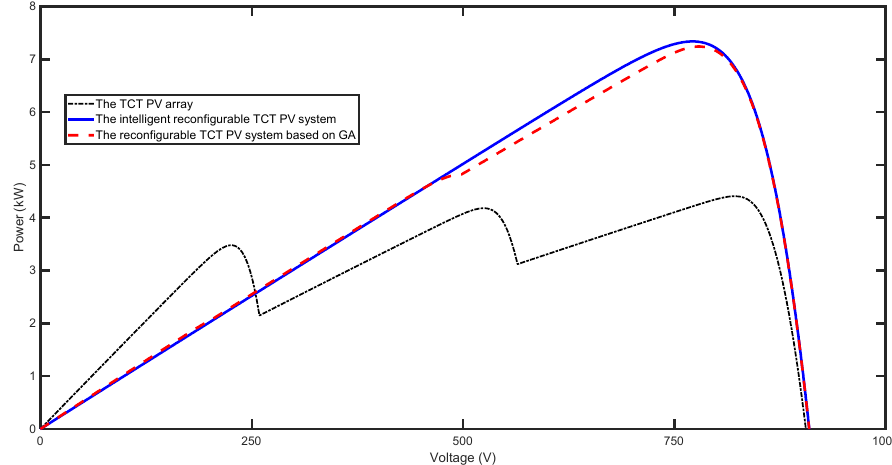
Figure 4. The P–V curves of PV array reconfiguration schemes.